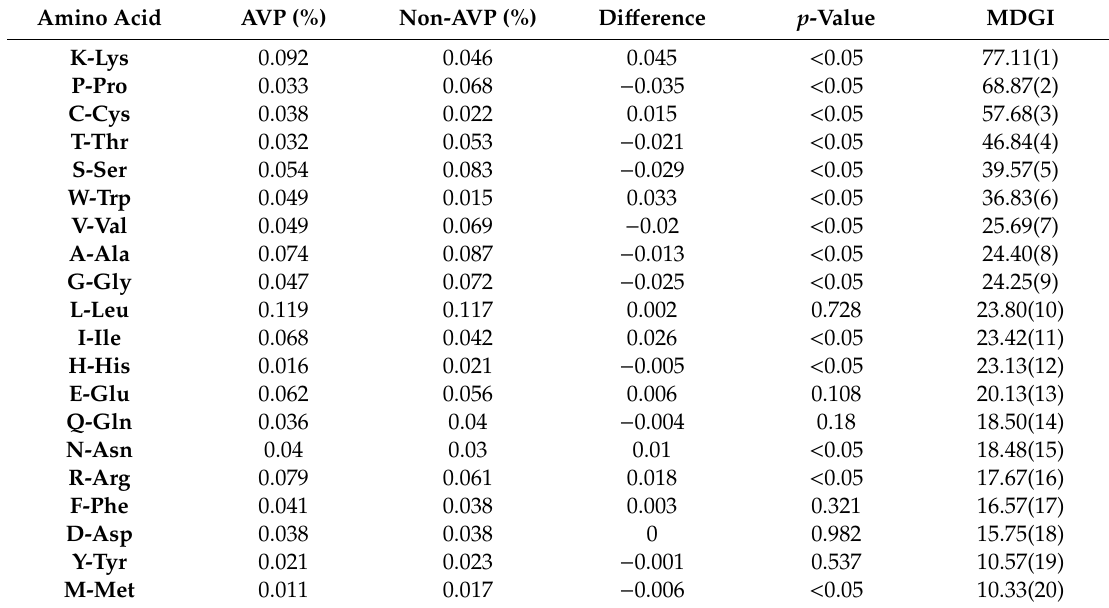
Table 3. Amino acid compositions (%) of AVP and Non-AVP along with their MDGI values on T 544p + 544n